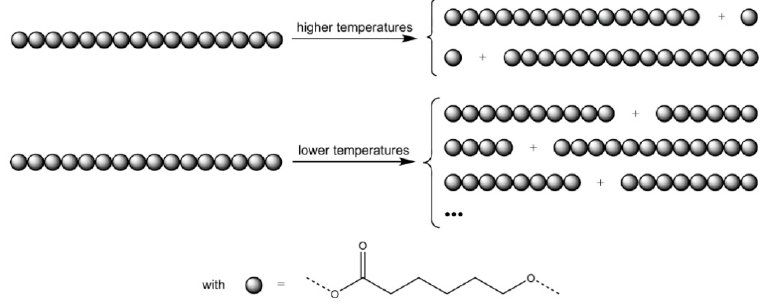
Figure 7. The chemical structure of polycaprolactone (PCL) (sphere) and degradation of PCL dependent on temperature. Reprinted from [67]. Copyright (2009) The Royal Society of Chemistry.